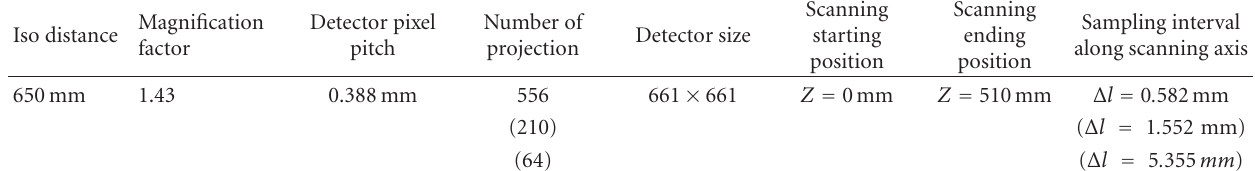
Table 2: Straight line scan